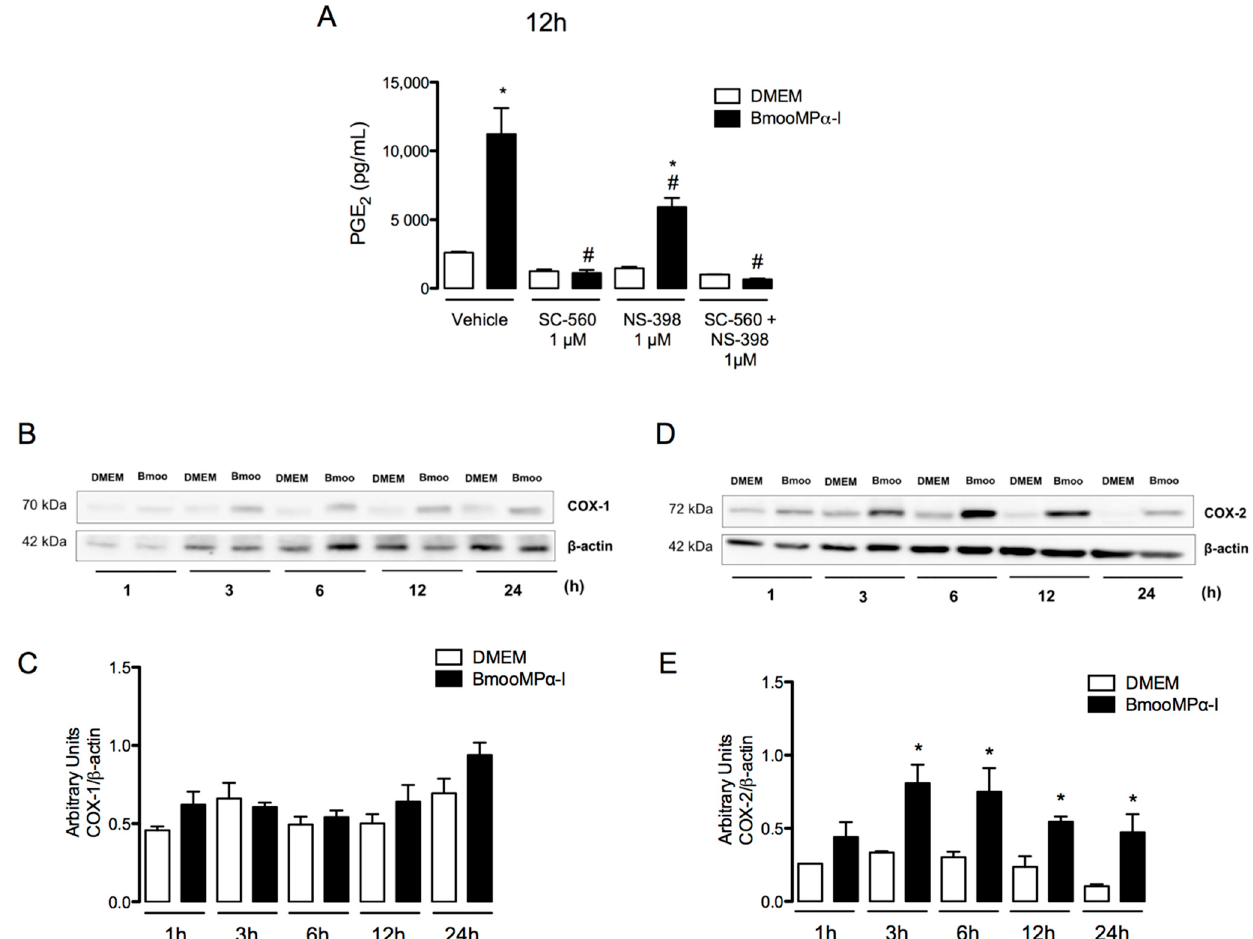
Figure 2. BmooMP α -I activates COX-1 and COX-2 pathways to release PGE 2 and upregulates COX-2 protein expression: ( A ) cultured preadipocytes were pretreated with the selective inhibitors of COX-1, COX-2, SC-560, and NS-398 for 1 h and incubated with BmooMP α -I (0.24 µ M) or DMEM (control) for 12 h, then supernatants were collected and PGE 2 was quantified by ELISA; ( B – E ) preadipocytes were incubated with BmooMP α -I (0.24 µ M) (Bmoo) or DMEM (control) for 1, 3, 6, 12, and 24 h; ( B ) representative Western blotting of COX-1 and β -actin (loading control) showing immunoreactive bands; ( D ) representative Western blotting of COX-2 and β -actin (loading control) showing immunoreactive bands; densitometric analysis of immunoreactive ( C ) COX-1 and ( E ) COX-2 bands. Data are means ± SEM of 4 samples. Note: * p < 0.05 relative to control; # p < 0.05 relative to BmooMP α -I (with vehicle); ( A ) one-way ANOVA and Bonferroni post-test; ( C , E ) two-way ANOVA and Bonferroni